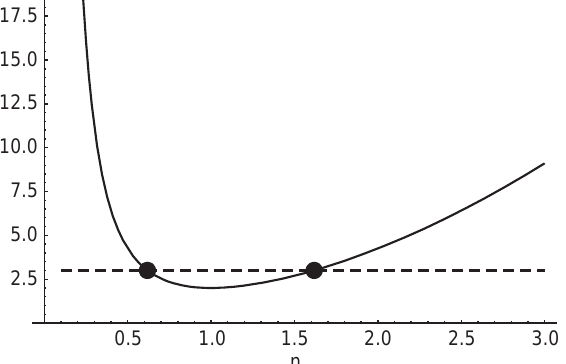
Fig. 12. The curve n c (cid:255) 1 (cid:135) a = n 2 as a function of n has, in general, two roots